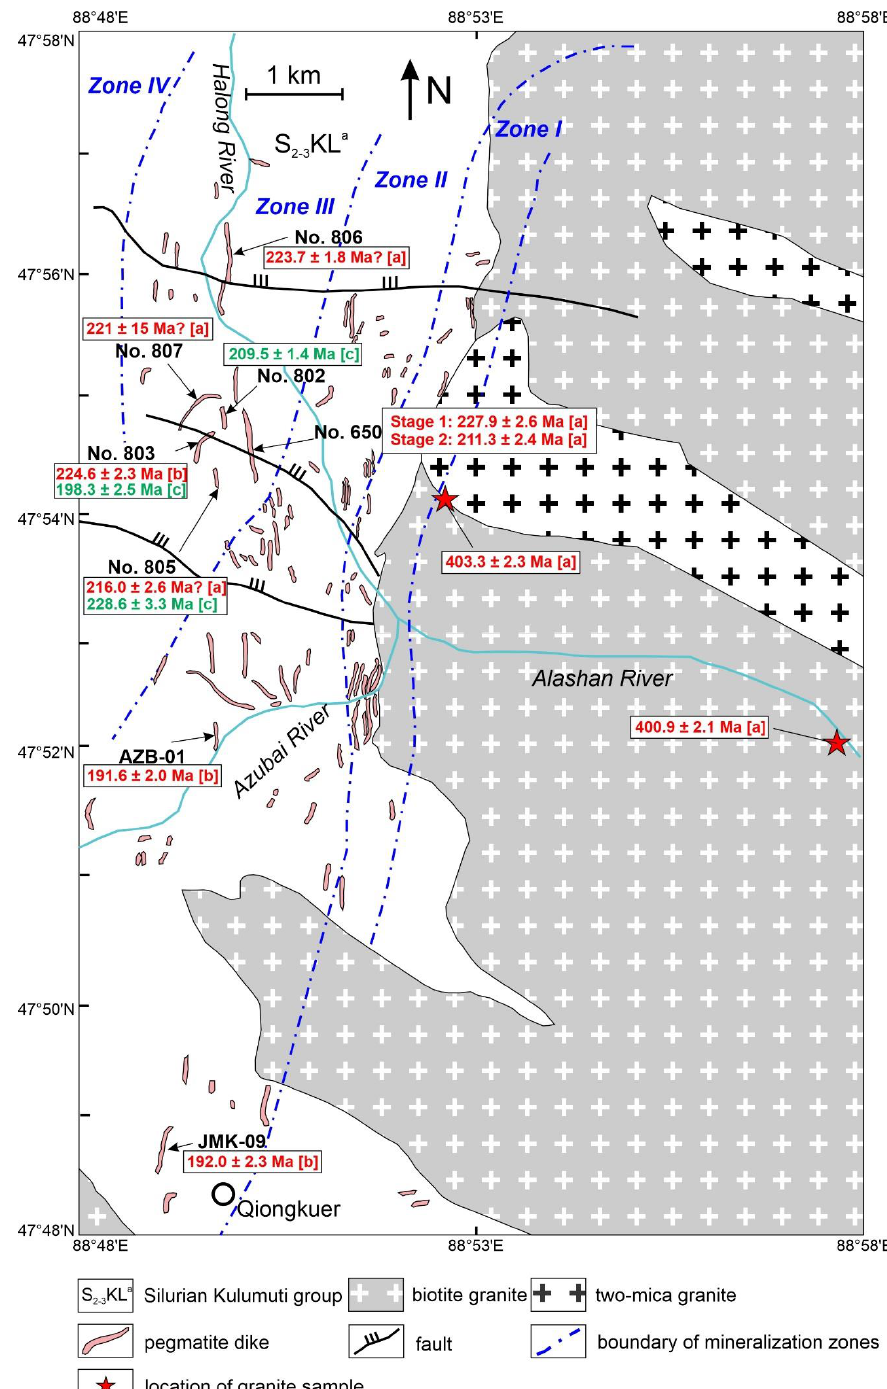
Figure 2. Schematic geological map of the Kalu’an-Azubai pegmatite field (after [3]). The age data for the representative Li pegmatites are obtained by ( a ) Ma et al., 2015 [3], ( b ) Zhang et al., 2016 [4], ( c ) this study. On the map, the age data obtained by previous studies are in red color whereas the ages obtained in this study are in green